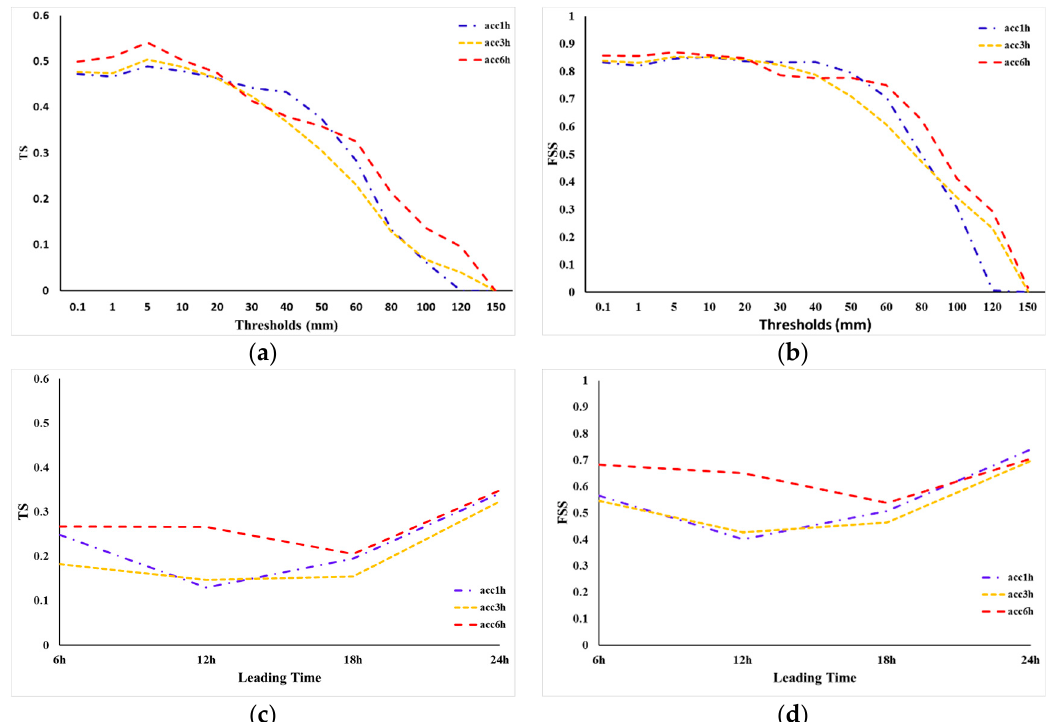
Figure 9. This is similar to Figure 7 but for sensitivity of rainfall forecast skill score to rainfall accumulated time within 6 h assimilation window.